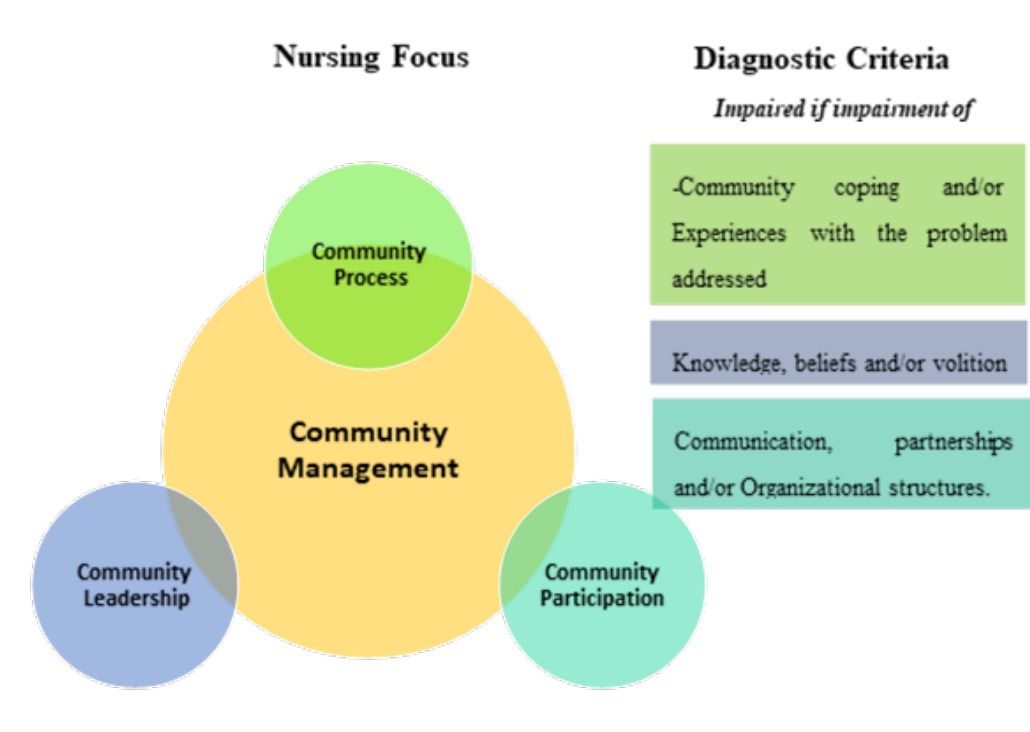
Figure 1. Clinical Decision Matrix components from Community Assessment, Intervention and Empowerment Model (MAIEC)